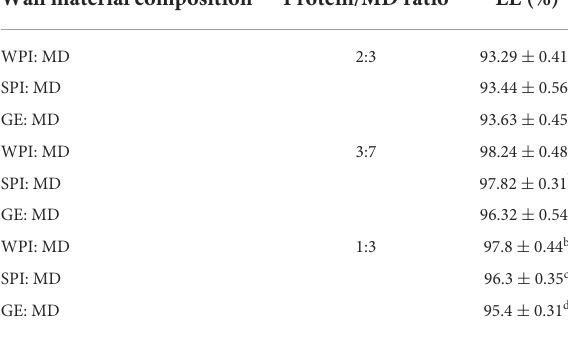
TABLE 1 Effect of protein/MD ratios on EE of